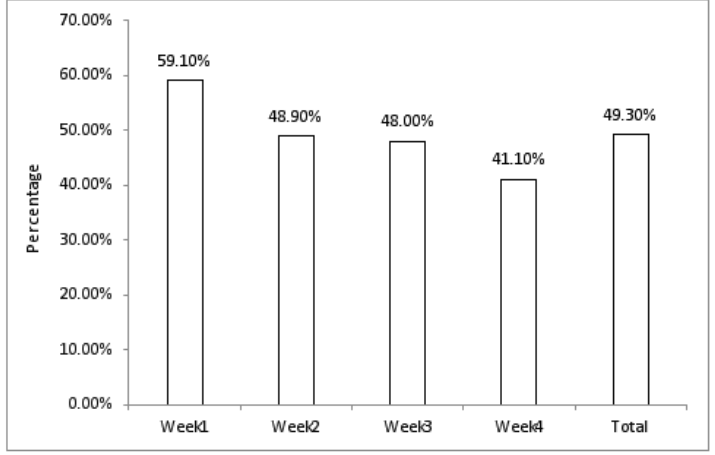
Figure 2. The weekly ecological momentary assessment (EMA) data in the experimental